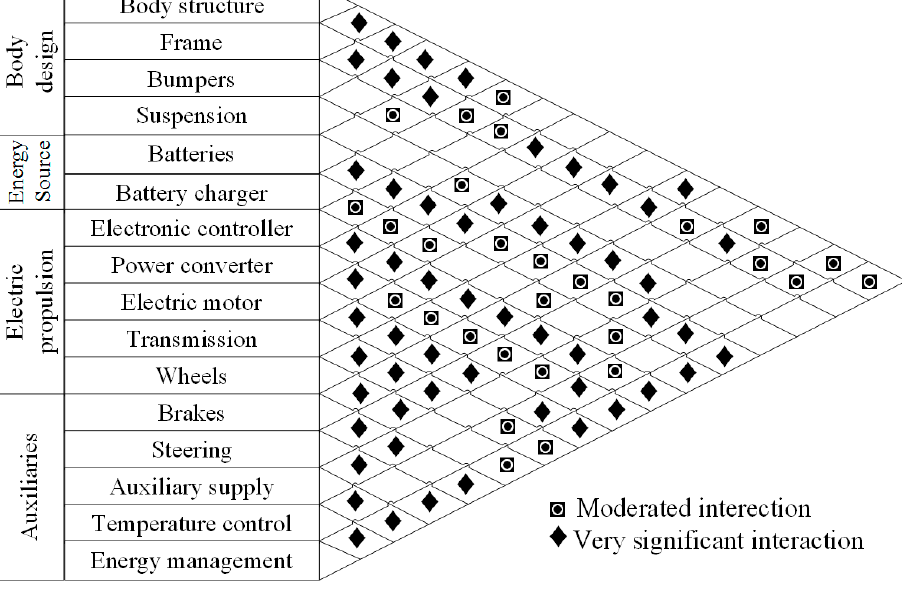
Figure 1. Major EV subsystems and their interactions. Some of the subsystems are very closely related while some others have moderated interactions. Data from [4].